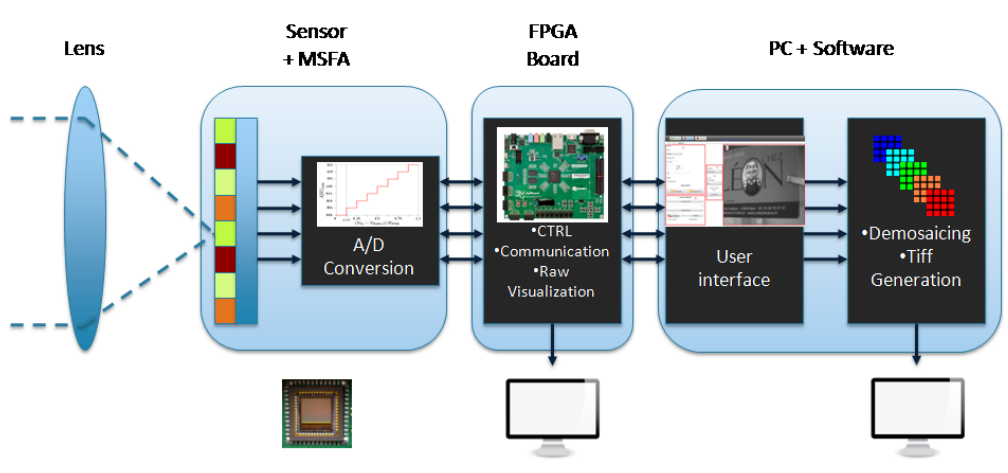
Figure 1. Overall architecture of the ad hoc imaging system. It is composed of four hardware blocks with dedicated features, through capture to processing. The video output can be visualized both before and after pre-processing, via respectively the FPGA board and the PC